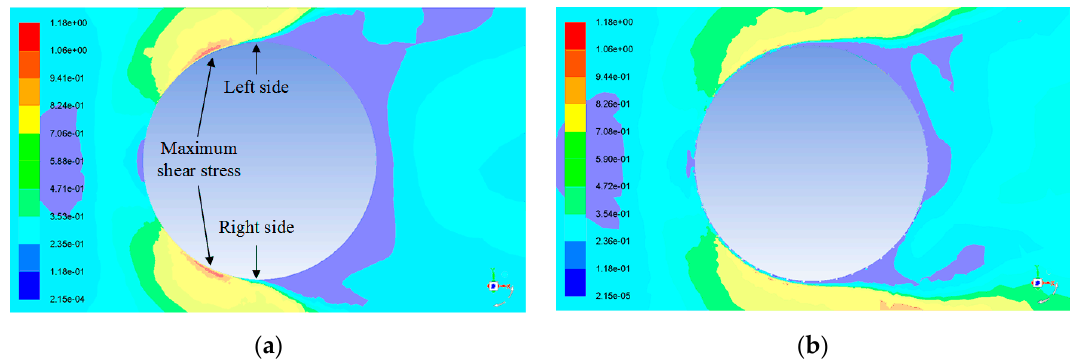
Figure 10. Shear stress on the surface of the seabed: ( a ) before using fishnet; ( b ) after using fishnet.